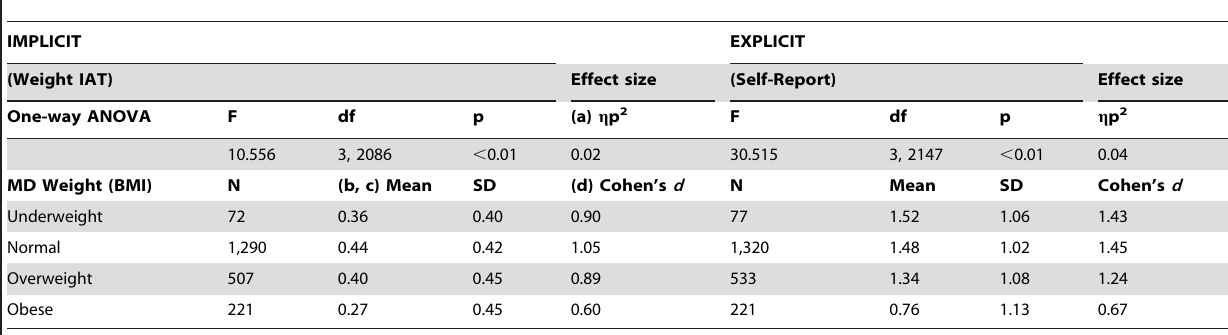
Table 4. Implicit and Explicit Attitude Measures for MDs (medical doctors) by BMI.